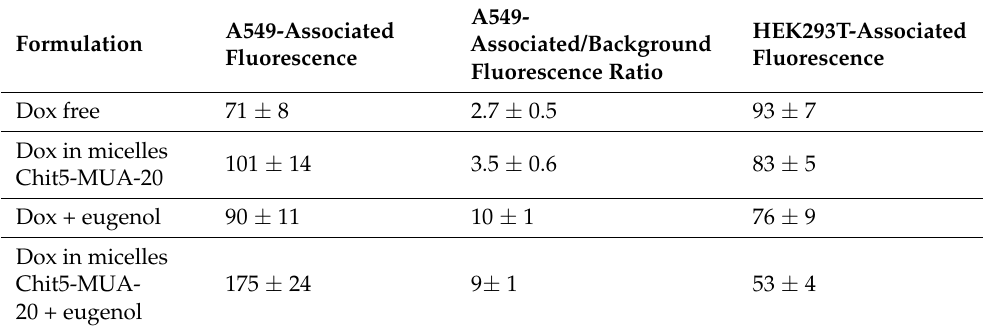
Table 4. A549- and HEK293T-associated fluorescence (conventional units) depending on the com- position of the Dox-containing formulation (10 µ g/mL). Determined by fluorescent image analysis and fluorescence quantification of Dox uptake by the absorption of solution over cells. PBS (0.01 M, pH 7.4). T = 37 ◦